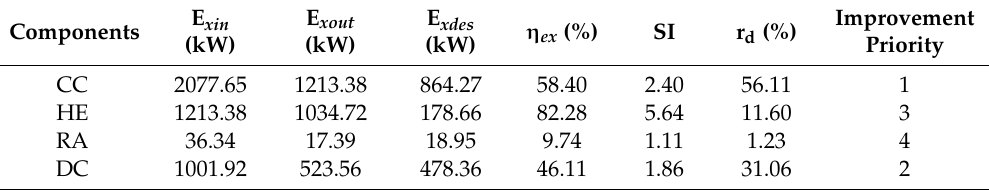
Table 4. Exergetic performance of the components for the whole dryer.